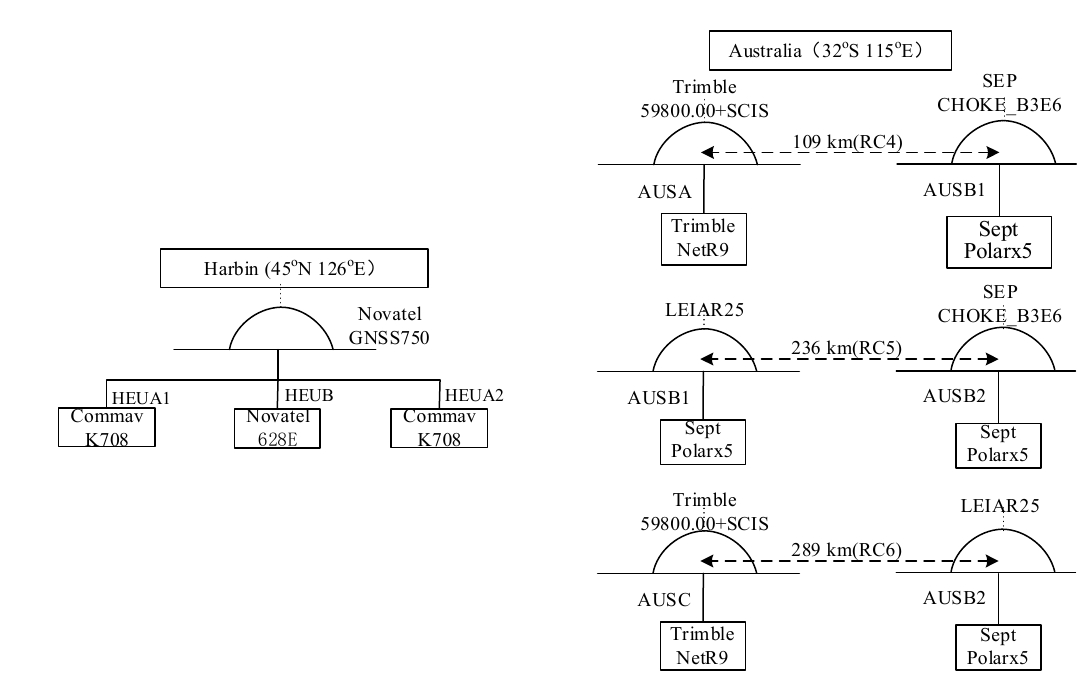
Figure 1. Receiver and antenna setups. Table 2. Baseline setups.